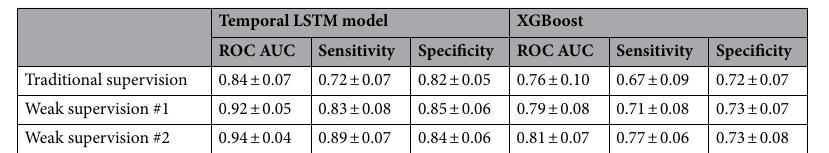
Table 1. Performance of the temporal LSTM and XGBoost models compared across all three supervision